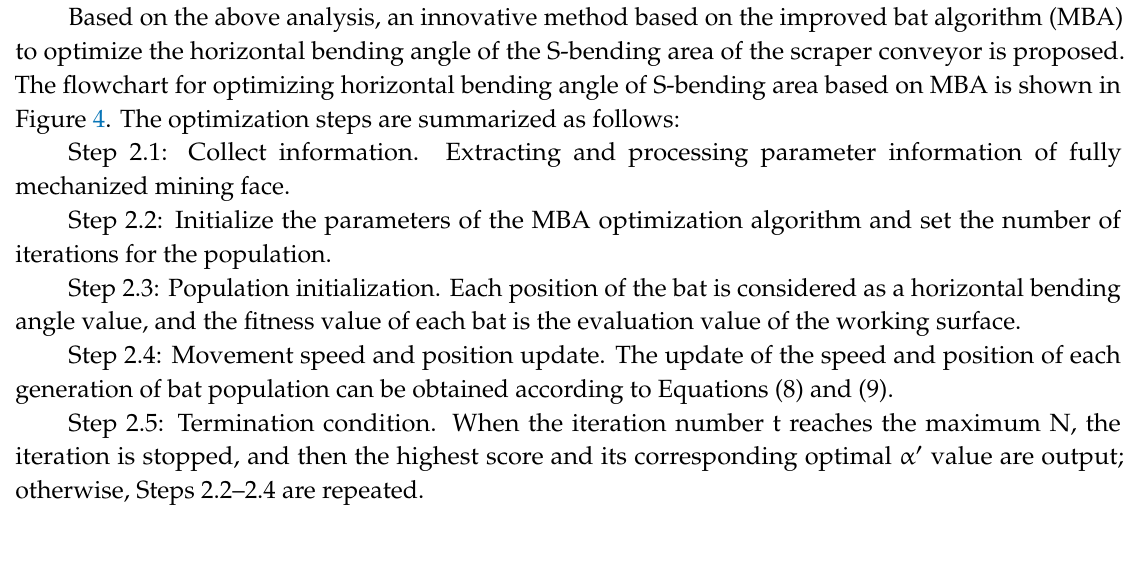
Extracting and processing parameter information of